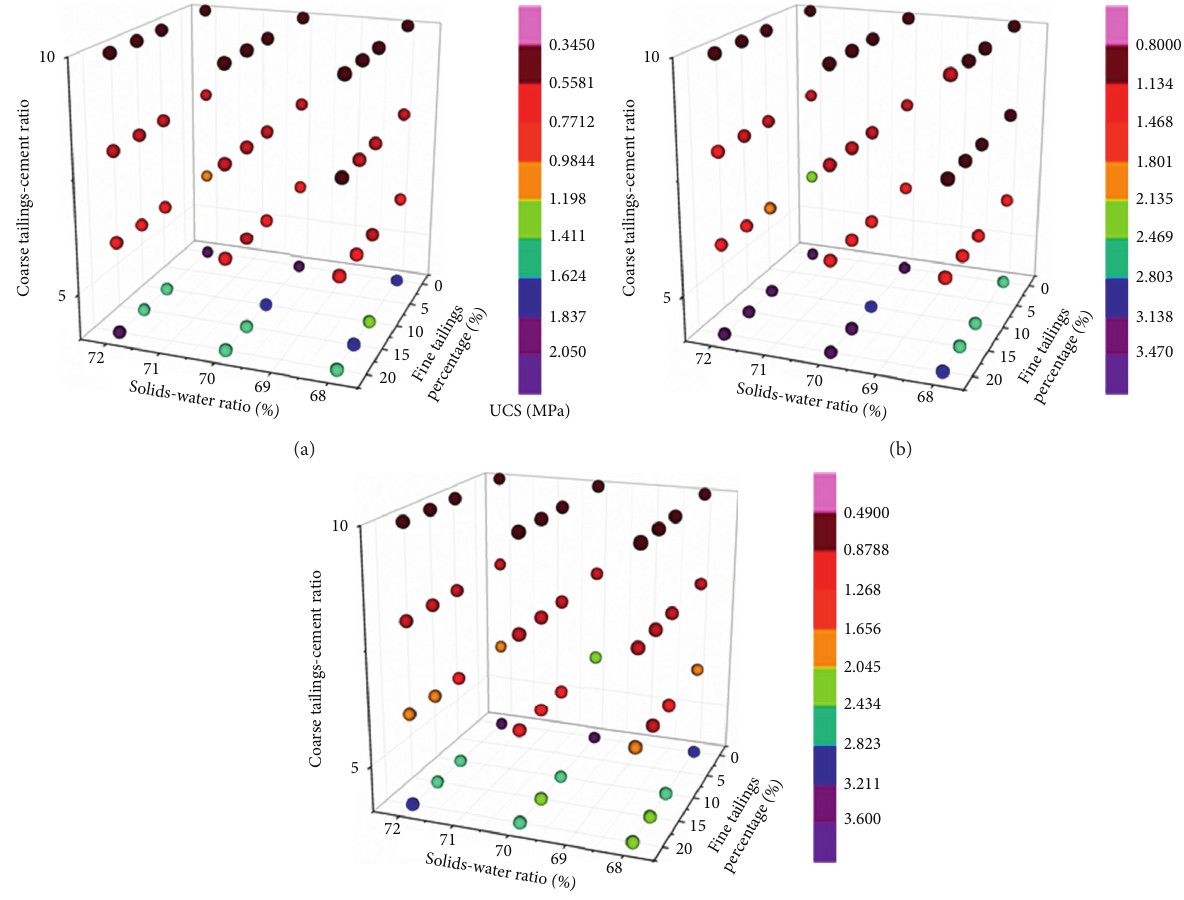
Figure 4: UCS test results of CPB in 4D: (a) 7 days; (b) 28 days; (c) 60